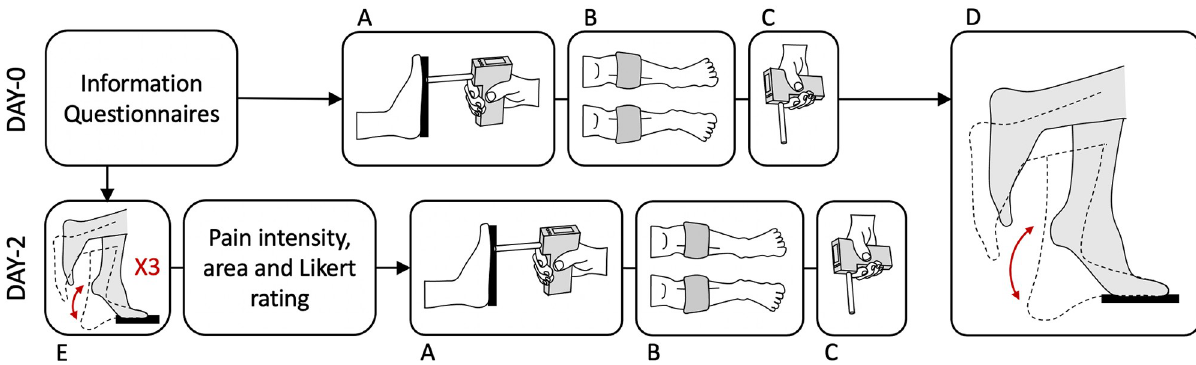
Fig 1. Overview of protocol showing timeline on Day-0 and Day-2 including: Initial information, questionnaires and ratings on Day-0, A—isometric force measurement, B—cuff algometry measurement of pain sensitivity, C—handheld pressure algometry measurement of pain sensitivity, D—delayed onset muscle soreness induction by calf raises, and E—assessment of pain intensity and area on contraction following 3 calf raises.